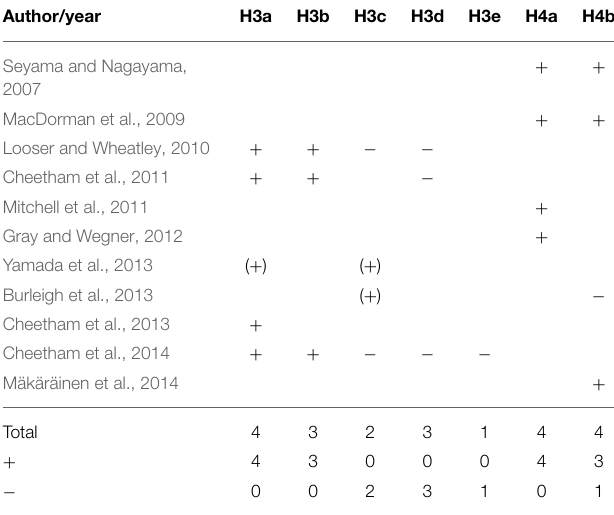
TABLE 5 | Empirical evidence for hypotheses H3 (categorization ambiguity) and H4 (perceptual